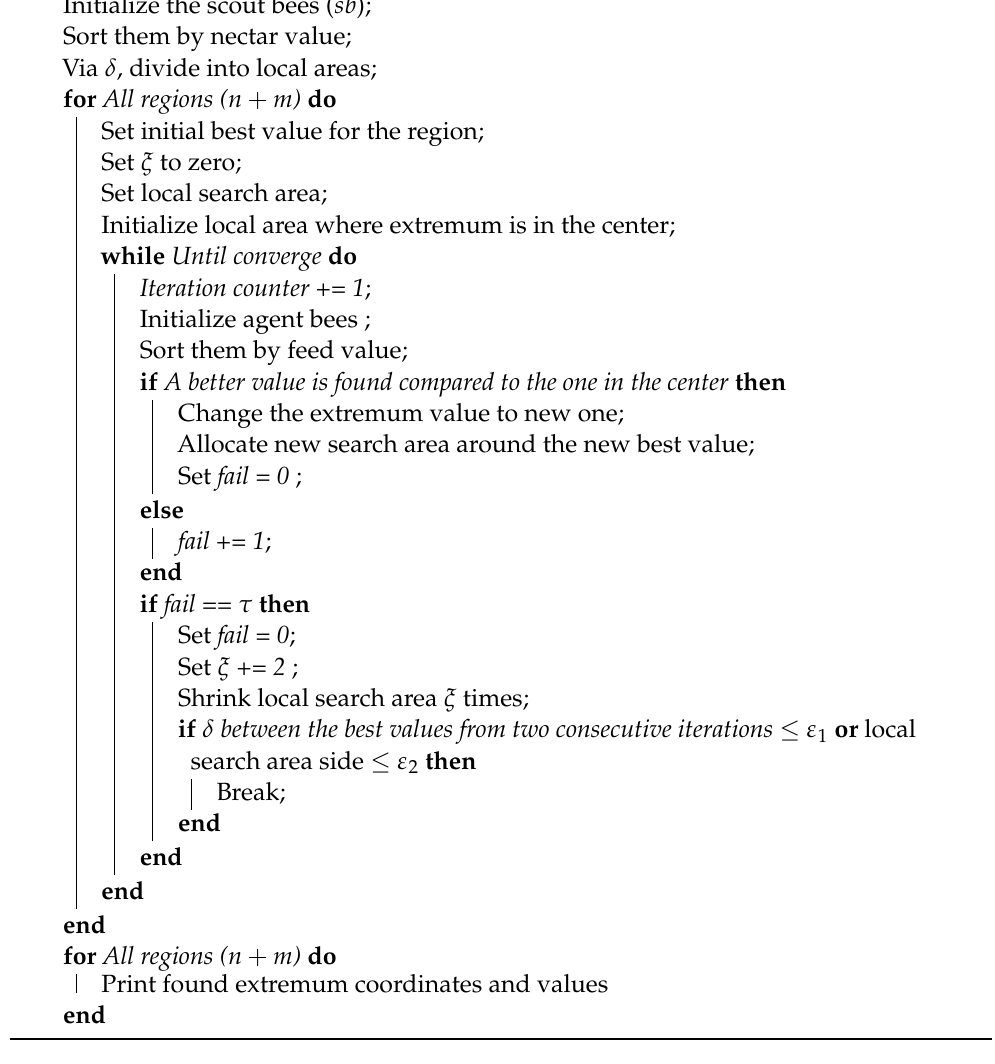
Algorithm 1: A modified Bee Colony algorithm